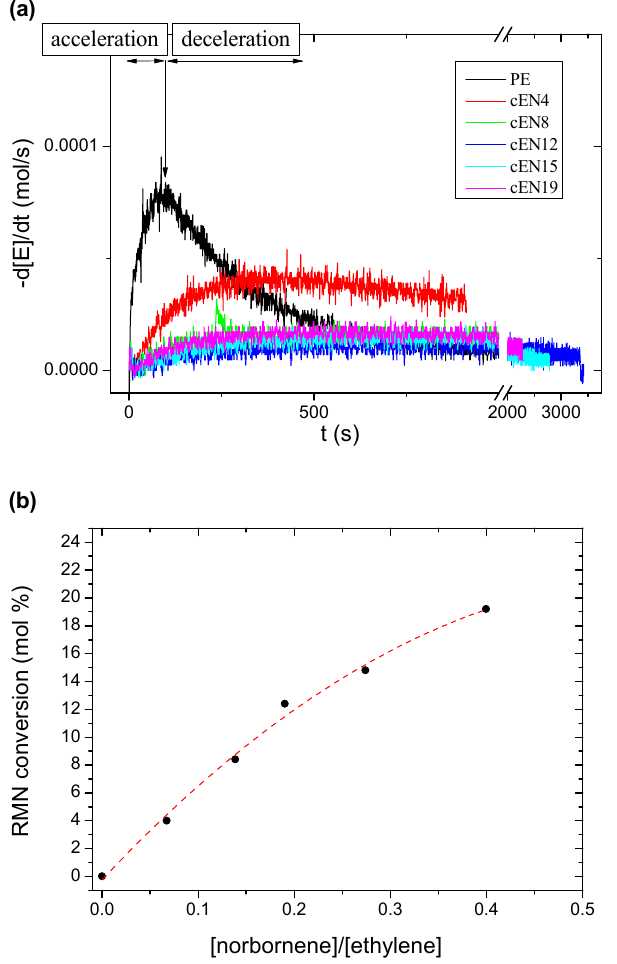
Figure 1. Polymerization kinetics for the homopolymer and copolymers ( a ), and molar % conversion regarding to the molar relationship between monomers ( b